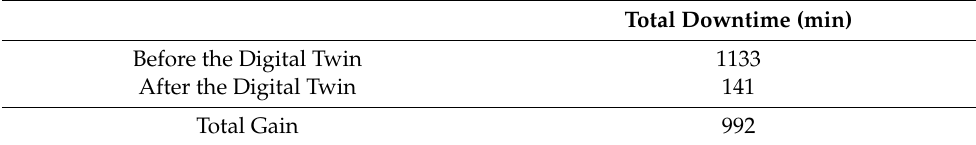
Table 4. Downtimes before and after using DT.